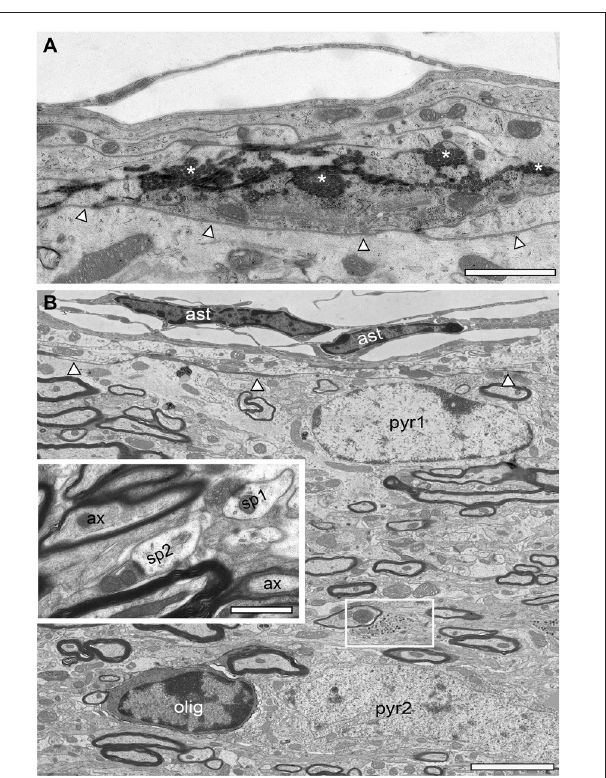
FIGURE 5 | Structural organization of the adult reeler mouse neocortex underneath the pial surface. (A) Low EM micrograph of the most superficial part underneath the pia mater of the reeler mouse neocortical mass. Note the long horizontally oriented bundles of collagen fibers (asterisks). The basal lamina is outlined by arrowheads. Scale bar 1 µ m. (B) Overview of the structural composition of the most superficial part in the adult reeler mouse neocortex. Here, the neuropil contains migrated, putative pyramidal neurons (pyr1, pyr2). Beside neurons, oligodendrocytes were also observed (olig) often associated with neurons and always with axonal bundles running parallel to the pial surface. Note a specialized type of synapses (small framed area) with high numbers of dense core vesicles predominantly found in this area shown at higher magnification in Figure 9B . Abbreviation: ast, astrocytes. The basal lamina is outlined by arrowheads. Inset, between the massive axonal bundles (ax), dendrites, spines (sp1, sp2) and synaptic boutons of various shape and size were regularly found. Scale bar 0.5 µ